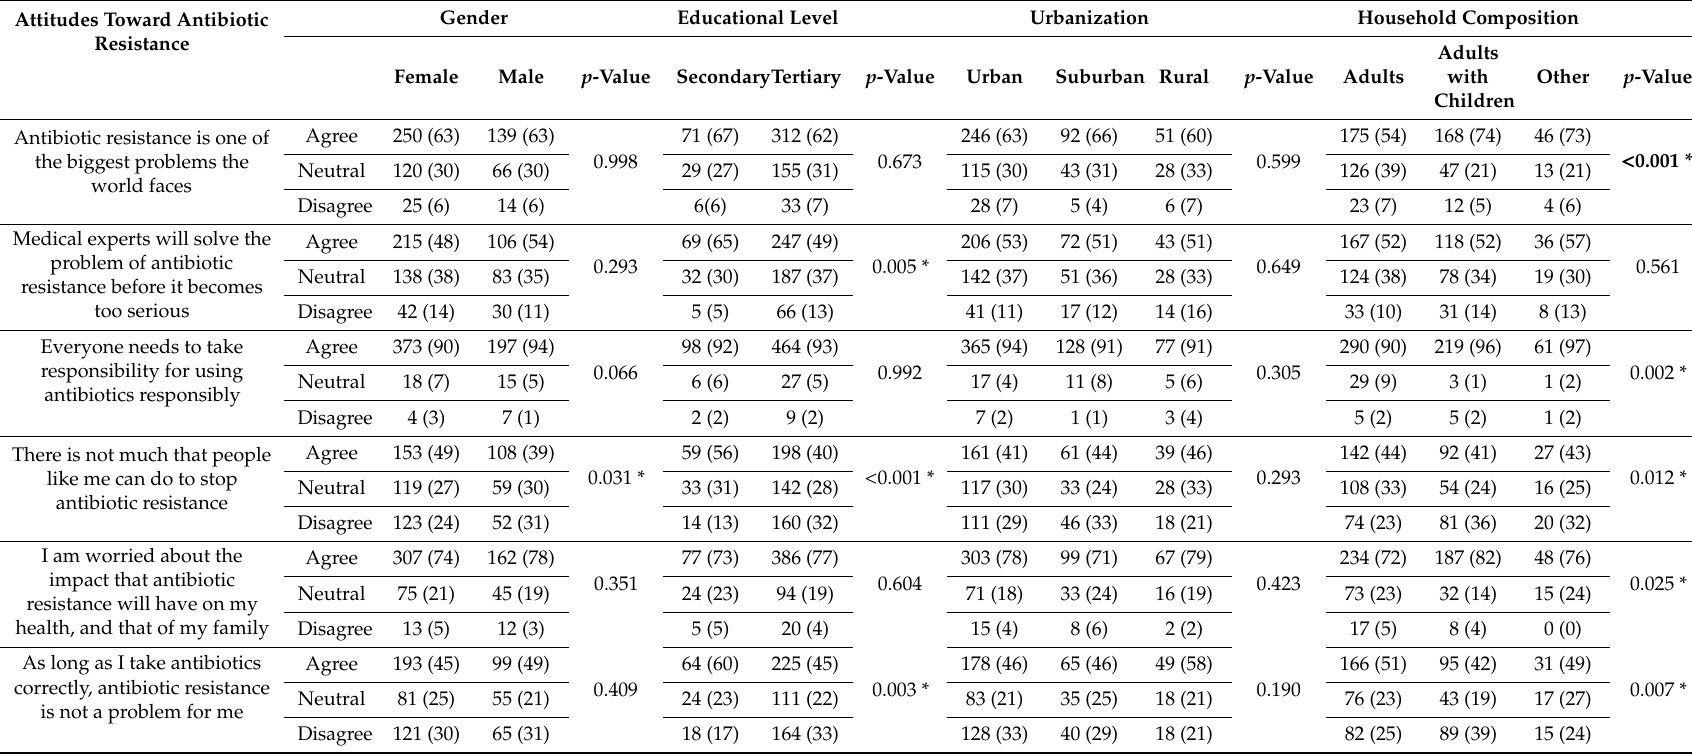
Table 3. Participants’ ( n = 614) attitudes toward antibiotic